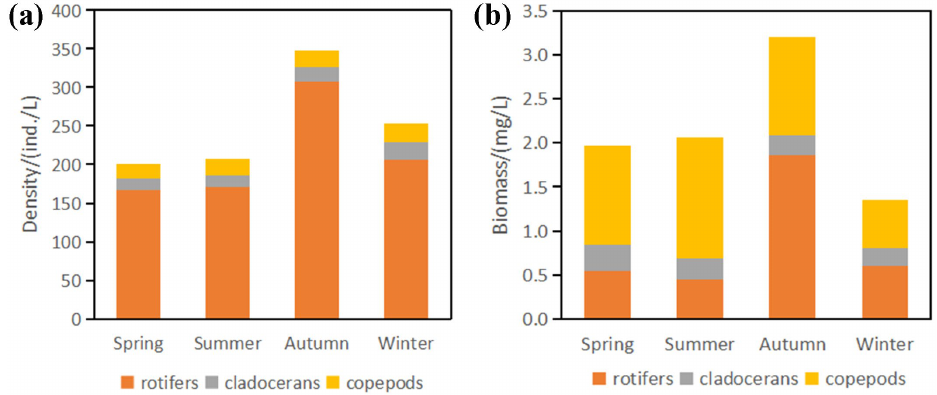
Figure 3. Seasonal distribution of zooplankton density ( a ) and biomass ( b ).